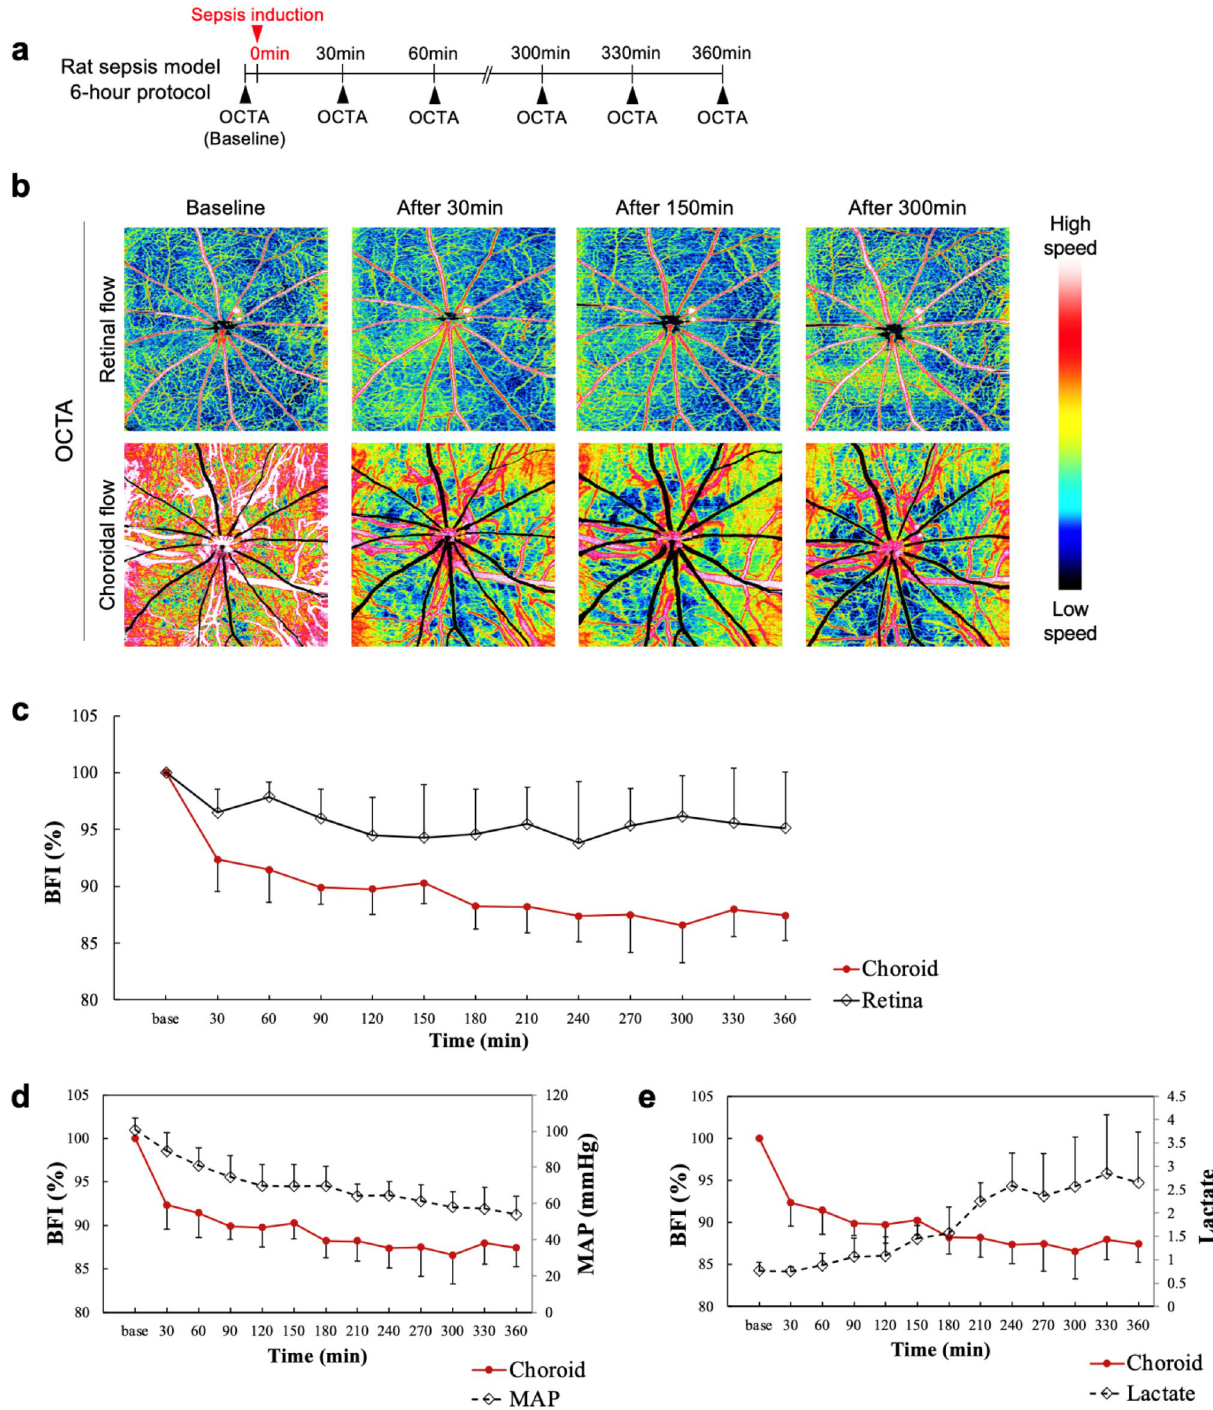
Figure 2. Blood flow change in 6-h severe rat sepsis model. For measuring acute change in blood flow speed, the animal received 7 ml/kg fecal slurry injection and underwent OCTA imaging every 30 min for 6 h ( a ). ( b ) Shows color-coded multi-interscan-time OCTA images of the retinal and choroidal layers from the 6-h protocol. The retinal and choroidal BFI value (mean ± SD, n = 5) changes over time are shown in ( c ). ( d , e ) Show the choroidal BFI change in parallel with mean arterial blood pressure (MAP) and blood lactate, respectively. Changes in BFI, MAP, and lactate are summarized in Table